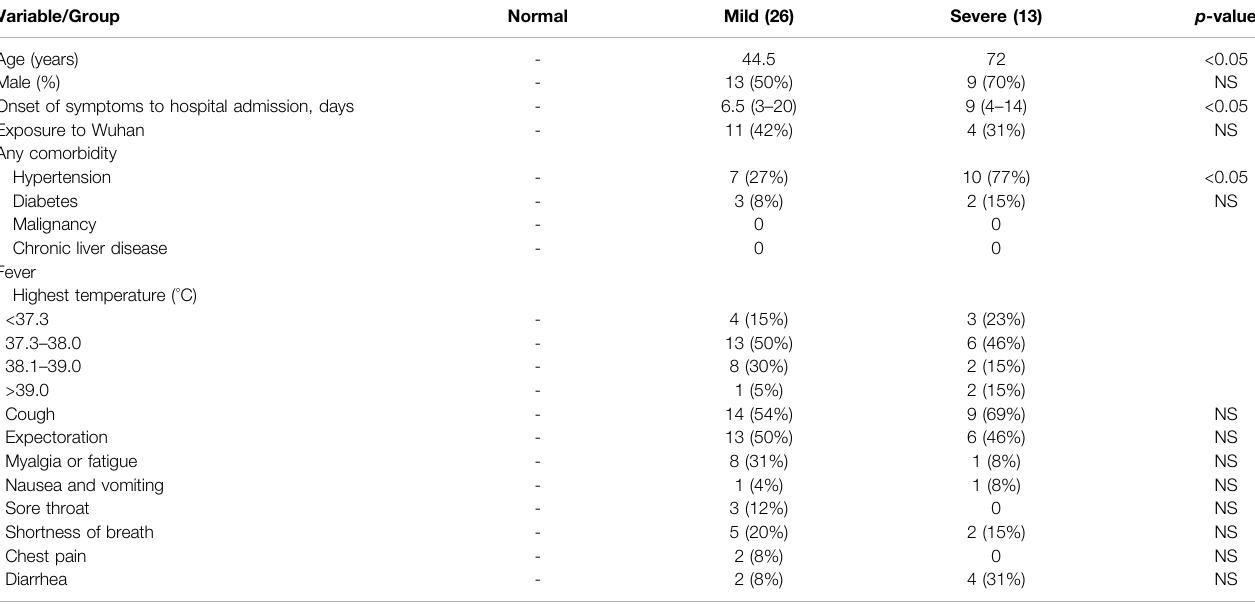
TABLE 1 | Demographics and clinical characteristics of all patients. Variable/Group